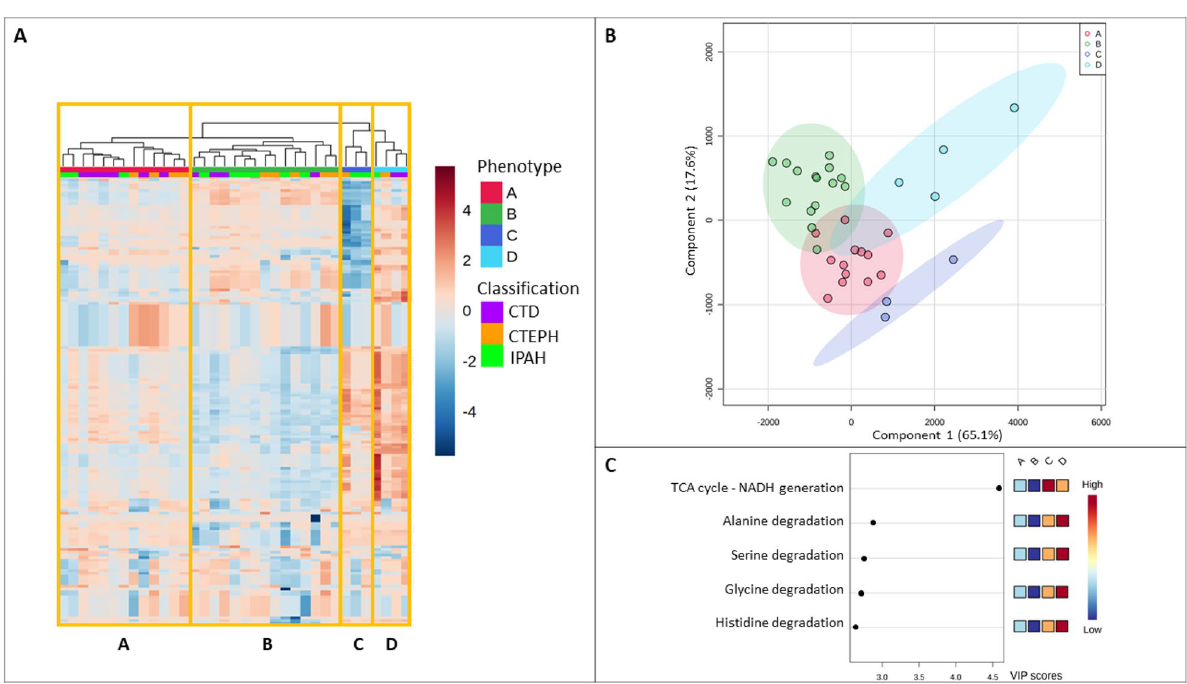
Figure 2. Four distinct intracellular EC metabolic clusters in patients with PH. ( A ) Heatmap displays EC intracellular metabolic activities, analysed using iEC3006, in 35 patients with PH. ( B ) Partial Least-Squares Discriminant Analysis, PLS-DA, identified different intracellular activities among PH phenotypes. ( C ) Top 5 list of variables of importance in the